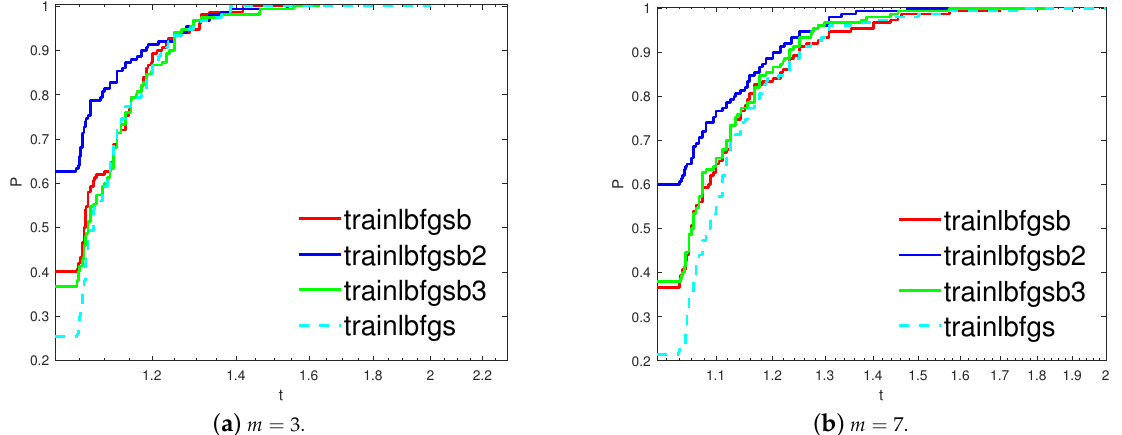
Figure 5. Log 10 scaled performance profiles based on accuracy for the diabetes classification problem.